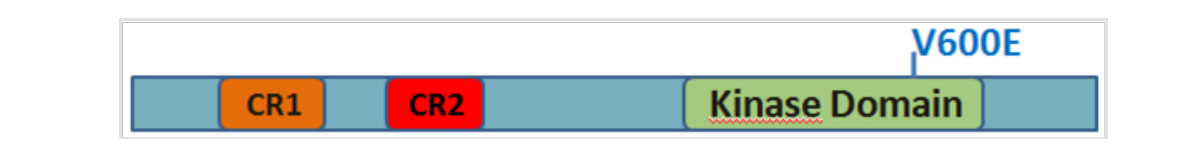
Figure 3. Schematic of BRAF V600E mutation. Functional domains of BRAF are depicted. CR1: conserved regions 1. CR2: conserved region 2.